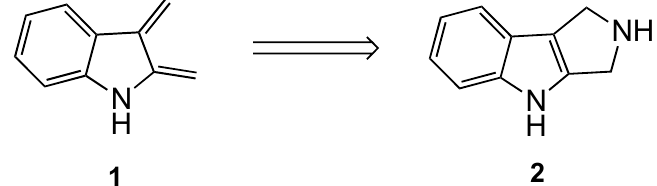
Figure 1. Retrosynthesis of indole-2,3-quinodimethane ( 1 ) from 1,2,3,4-tetrahydropyrrolo[3,4- b ]indole ( 2 ).